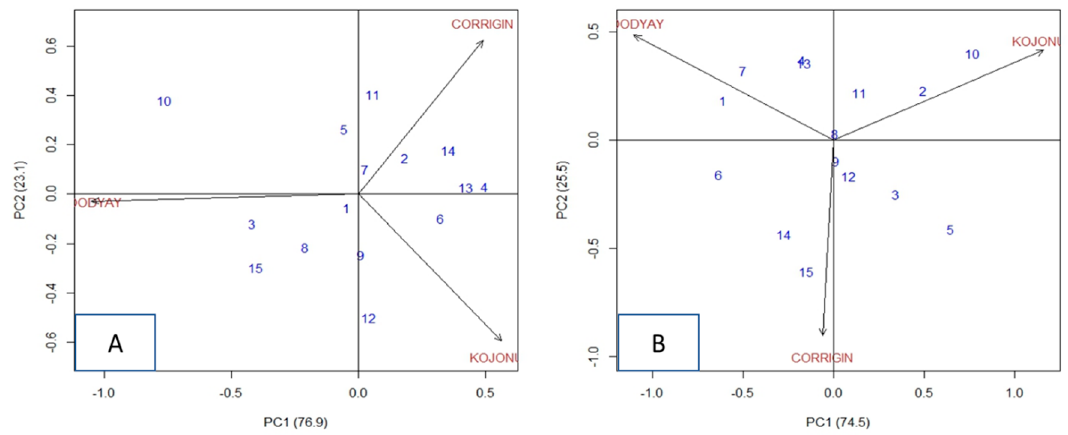
Figure 2. Additive main effects and multiplicative interactions (AMMI) biplot for allelic combination and environmental interaction on ( A ) yield and ( B ) protein content. Genotypes positioned near the origin of the biplot represent stability across the environments and close to an environment represent best performance in that corresponding environment.